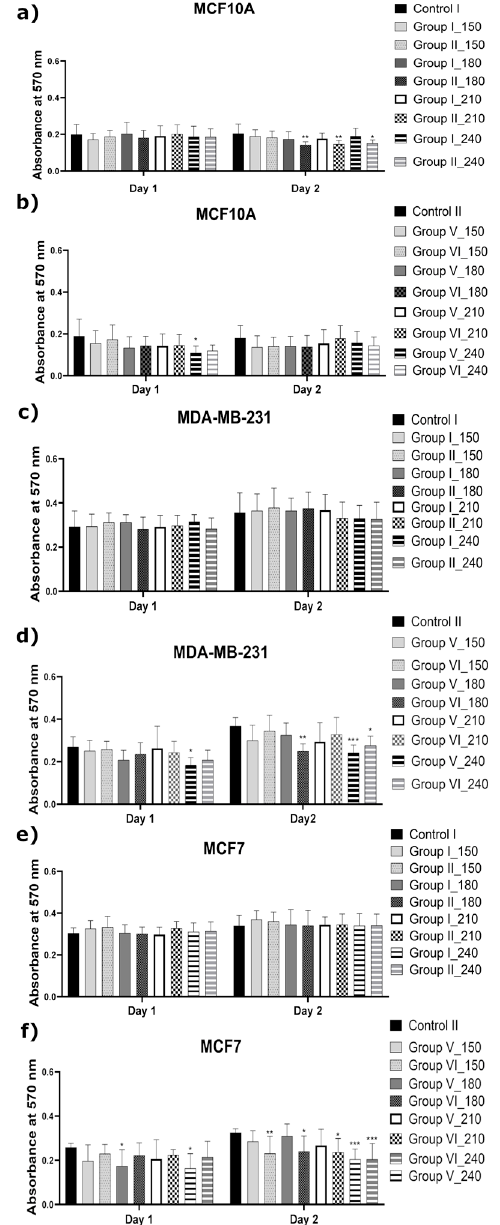
Figure 1. The MTT assay for the proliferation of human metastatic breast cancer (MDA-MB-231), human non-metastatic breast cancer (MCF7), and non-cancerous human normal (MCF10A) cell lines, incubated from 0 to 2 days in the cold atmospheric pressure plasma (CAPP)-activated media (exposure times of 150 s, 180 s, 210 s, or 240 s). ( a , c , e ) The MCF10A, MDA-MB-231, and MCF7 cell lines incubated in 3.0 mL (Group I) or in 1.5 mL (Group II) of the CAPP-activated DMEM. ( b , d , f ) The MCF10A, MDA-MB-231, and MCF7 cell lines incubated in 3.0 mL (Group V) or 1.5 mL (Group VI) of the CAPP-activated Opti-MEM. In both cases, fetal bovine serum (FBS) was added to the analyzed medium before the CAPP treatment. As a control, cells untreated by a CAPP-activated medium were used (Control I as the untreated DMEM and Control II as the untreated Opti-MEM). Data are means ± SD values for three independent experiments conducted in triplicates. The statistical calculation was performed by a comparison of all investigated groups versus the control using one-way analysis of variance (ANOVA) with the Dunnett’s post hoc test. (* p < 0.01; ** p < 0.001; *** p <